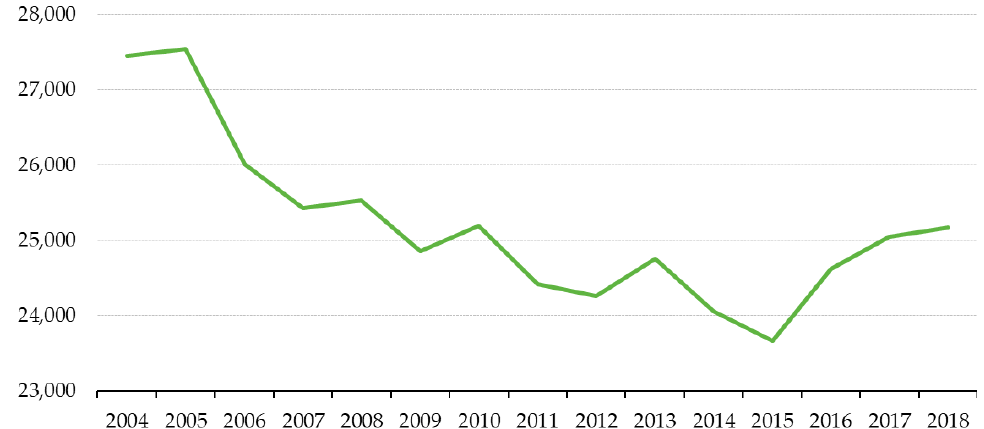
Figure 1. Energy consumption by agriculture in EU in thousand tonnes of oil equivalent. Reproduced from [42], Eurostat: 2021.